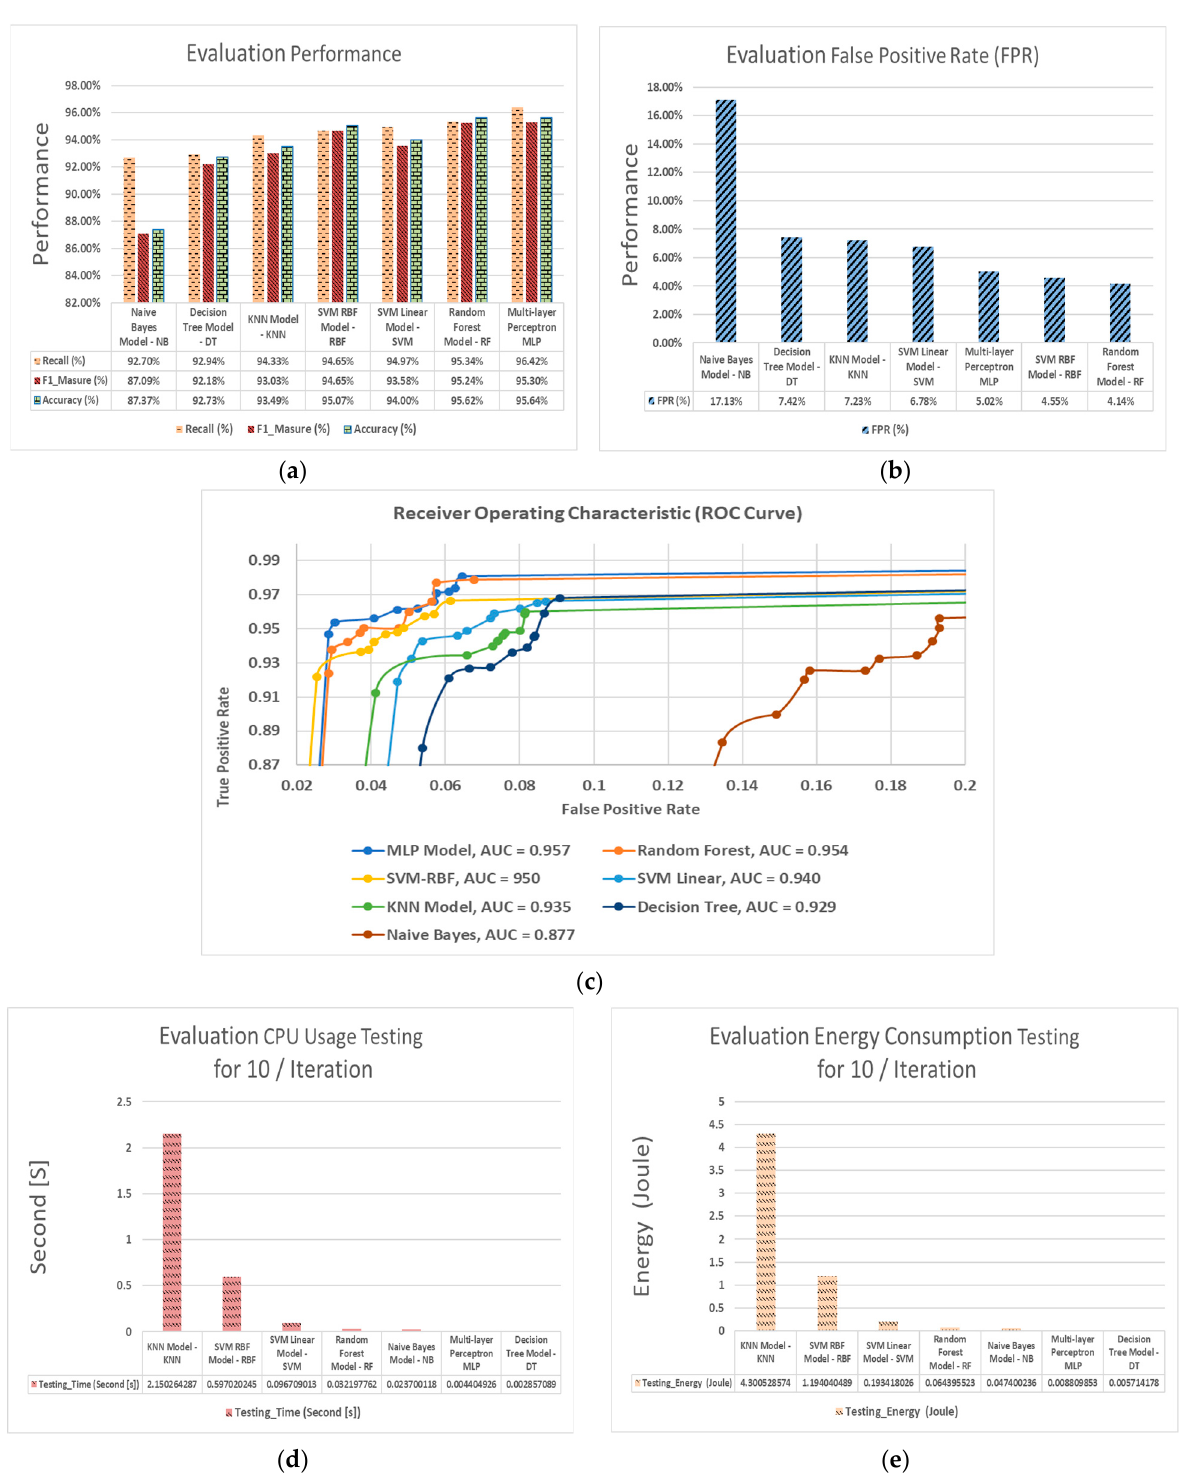
Figure 9. Performance of the classification methods: ( a ) comparison of recall, F1-Measure, and accuracy between different classifiers; ( b ) comparison of FPR between different classifiers using 1-gram and 2-gram; ( c ) comparison of ROC between the different classifiers using 1-gram and 2-gram; ( d ) comparison of CPU usage for testing time between the different classifiers using 1-gram and 2-gram; ( e ) comparison of energy consumption for testing time between the different classifiers using 1-gram and 2-gram.